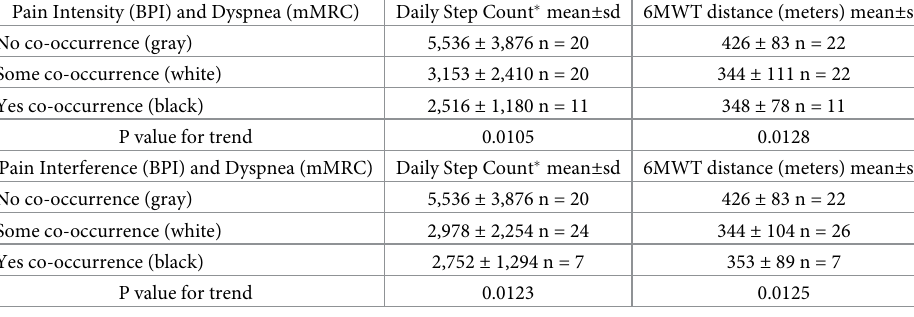
Table 6. a and 6b. Co-occurring pain and dyspnea are associated with lower daily step count and 6MWT distance. n = 55. Pain Intensity (BPI) and Dyspnea